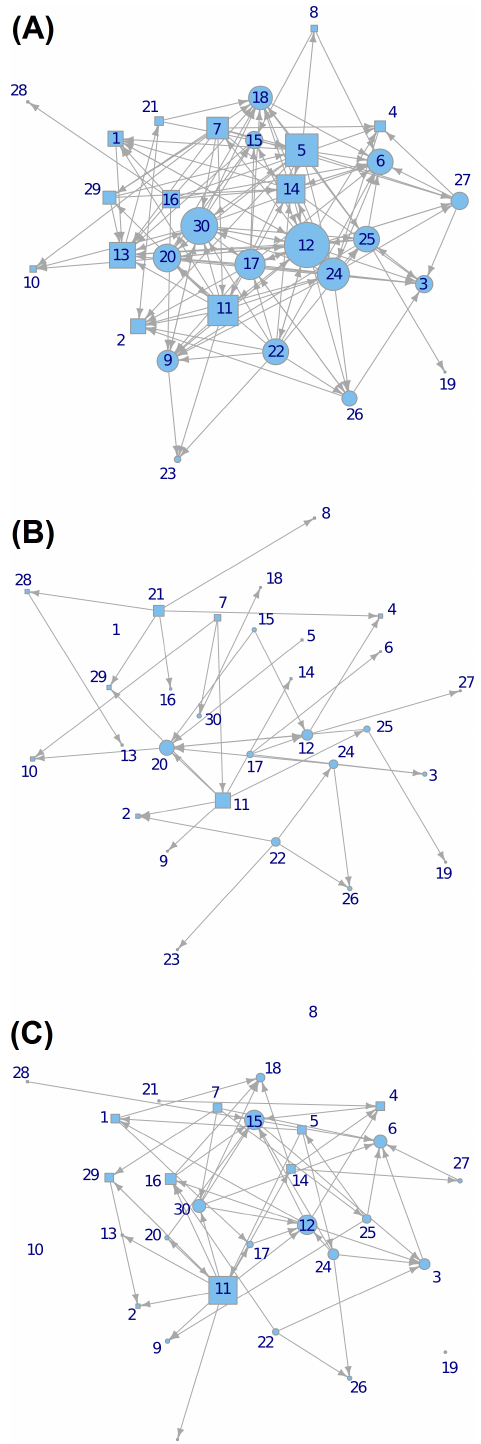
Fig. 5. Plant circulation subnetworks. (A) Starchy foods (density = 0.16). (B) Side dish foods (density = 0.04). (C) Snack foods (density = 0.06). Women are represented by circles and men by squares. Node size is proportional to the total degree (in-degree plus